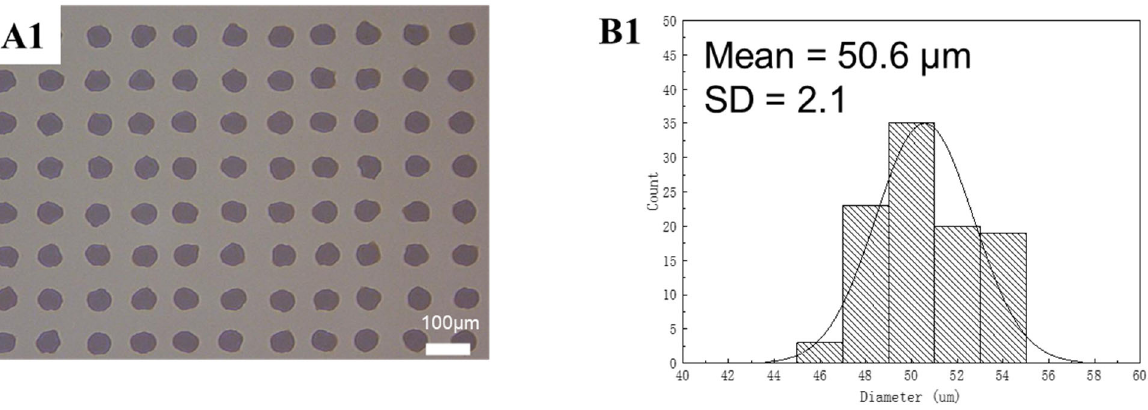
Figure 7. ( A1 ) The microscope image of the printed PDMS dot array on sapphire, ( B1 ) Diameter distribution of the printed PDMS dot array (from arrays of 10 × 10) on sapphire. The standard deviation (SD) was less than 2.53 or approximately 5% of the mean.